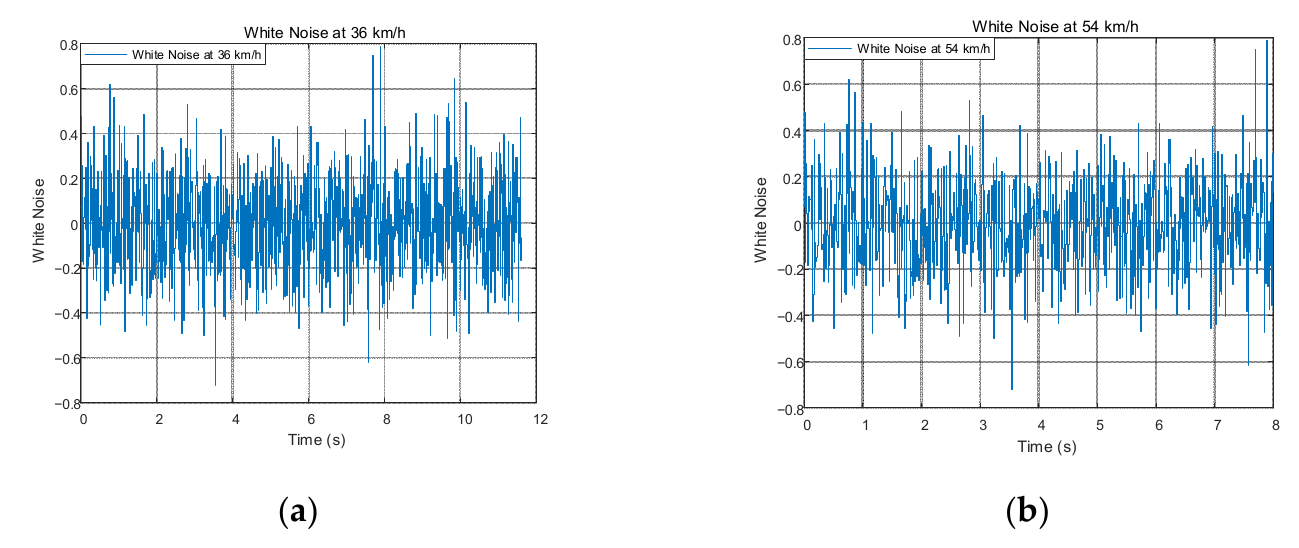
Comparison of the lateral acceleration of the ST algorithm at different speeds 36 km/h Lateral Acceleration